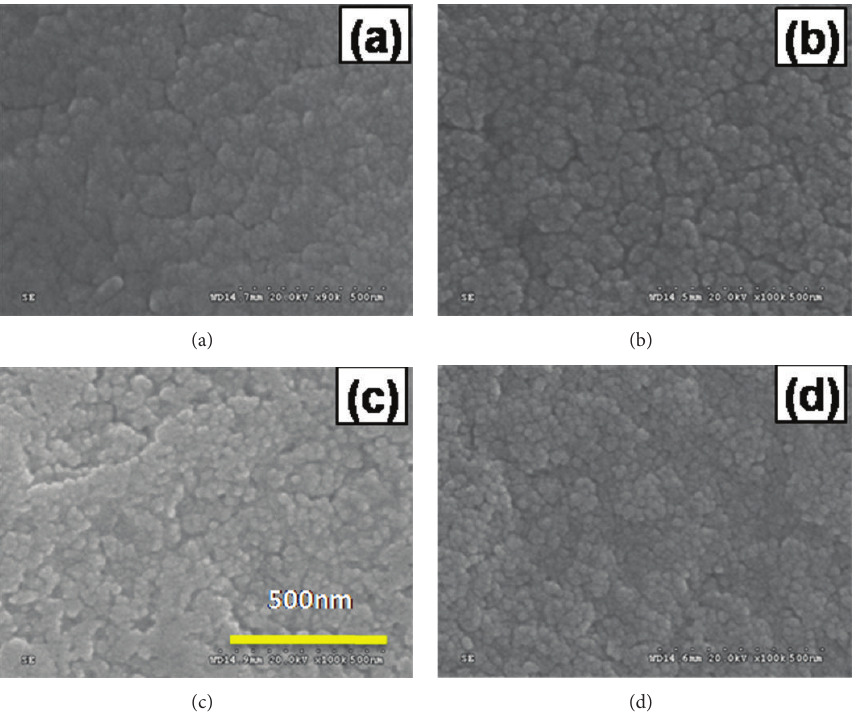
Figure 4: FESEM images showing the surface morphology of the doped ZnO films with different Cu doping concentrations. (a) 0.1 𝜇 M Cu 2+ , (b) 0.3 𝜇 M Cu 2+ , (c) 1.3 𝜇 M Cu 2+ , and (d) 26.4 𝜇 M Cu 2+